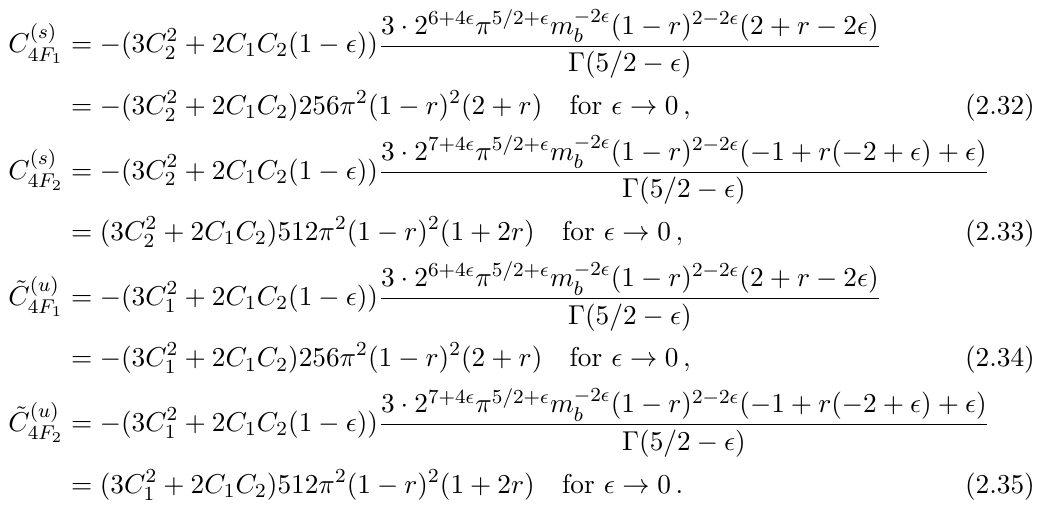
JHEP01(2021)051